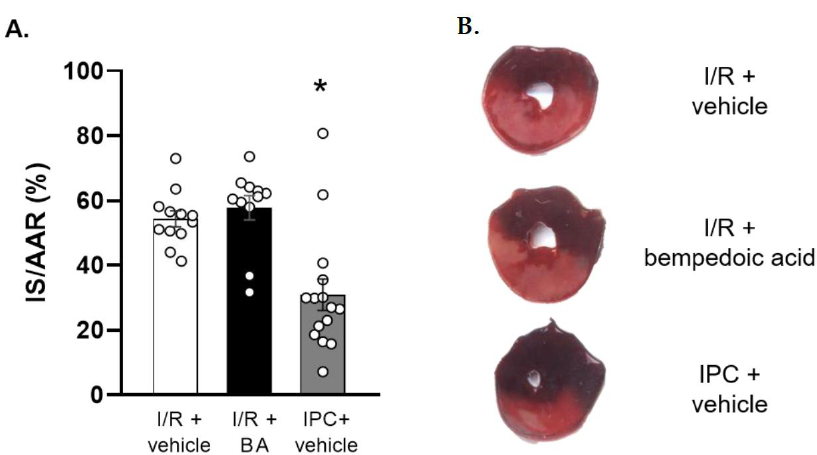
Figure 3. Myocardial infarct sizes. ( A ) Chronic bempedoic acid treatment does not influence infarct size compared to vehicle treated animals, while the positive control IPC significantly reduces it. Results are presented as means ± SEM. * p < 0.05 vs. I/R + vehicle and I/R + BA groups, Kruskal–Wallis test, followed by Dunn’s post hoc test, n = 11 – 15/group. ( B ) Representative triphenyltetrazolium-chloride-stained slices. BA: bempedoic acid. IS: infarct size. AAR: area at risk. IPC: ischemic preconditioning. I/R: ischemia/reperfusion.